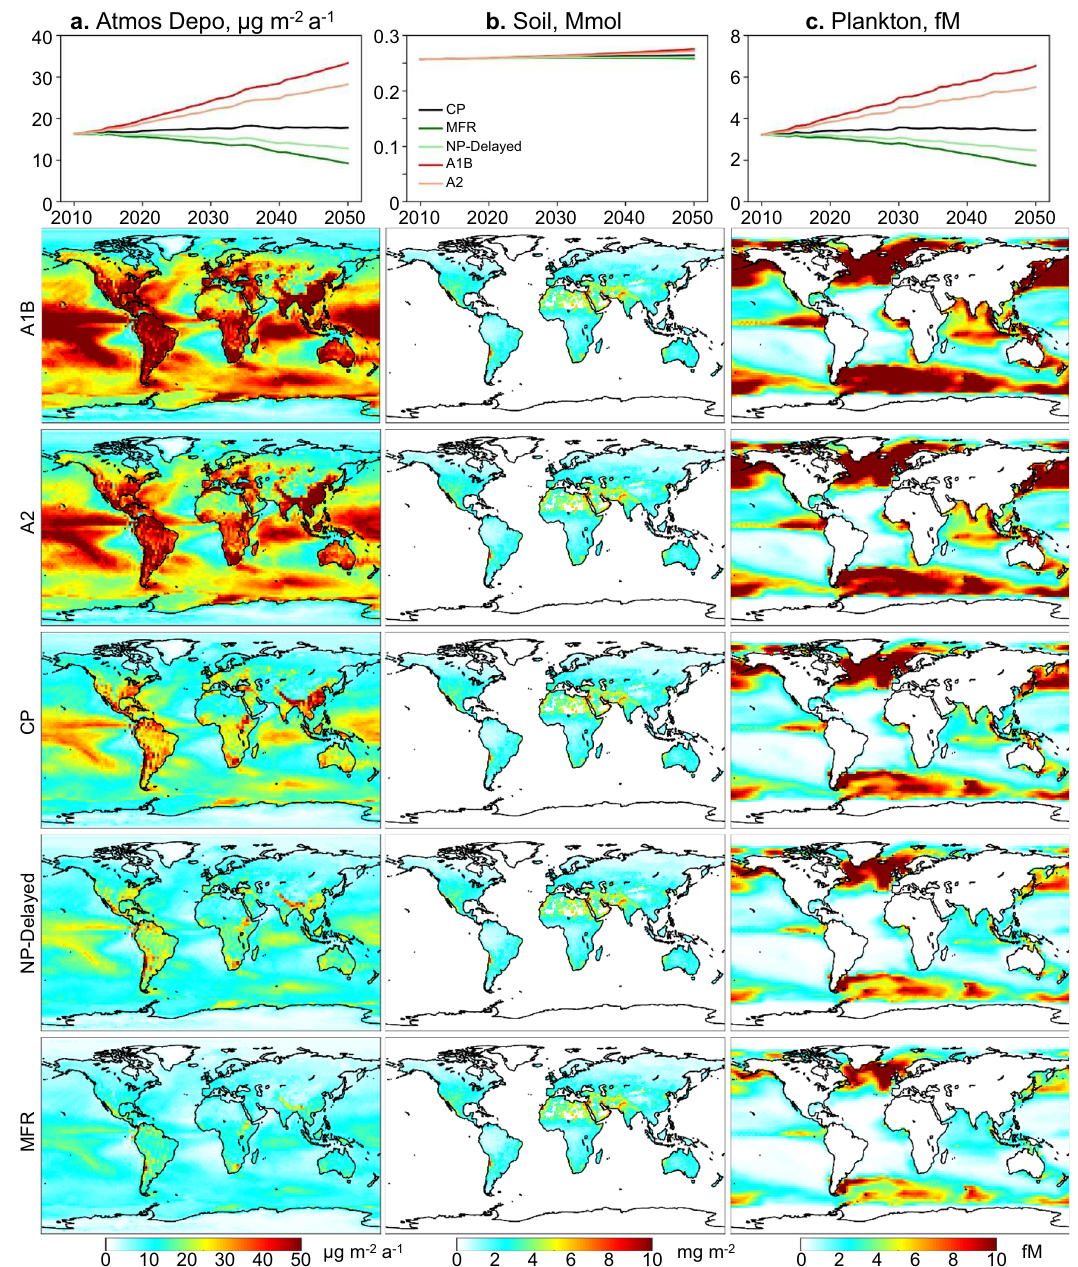
Fig. 3 Projected mercury levels in the environment in 2050. The column ( a ), ( b ), and ( c ) is for atmospheric deposition, soil, and marine plankton, respectively. For each column, the top panel shows the trend of global mean values, while the lower panels are the spatial distribution for the fi ve scenarios (with emission from highest to lowest): A1B (business as usual), A2 (divided world scenario), CP (current policy), NP-Delayed (new policy delayed), and MFR (maximum feasible